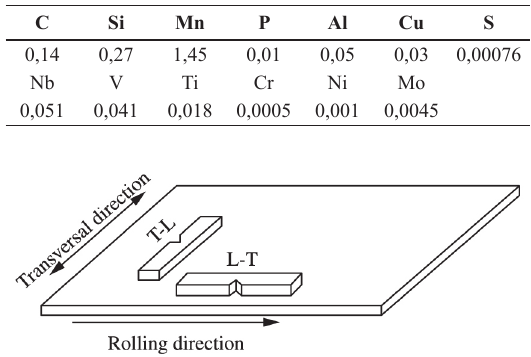
Figure 2. Schematic representation of the orientation notch in directions T-L and L-T for the impact